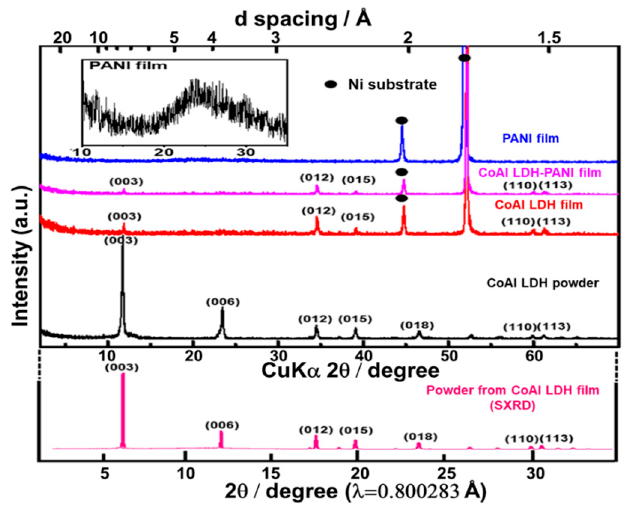
Figure 3. XRD patterns of CoAl LDH powder, CoAl LDH film, CoAl LDH-PANI film, PANI film, and SXRD patterns of the powder obtained from CoAl LDH film.